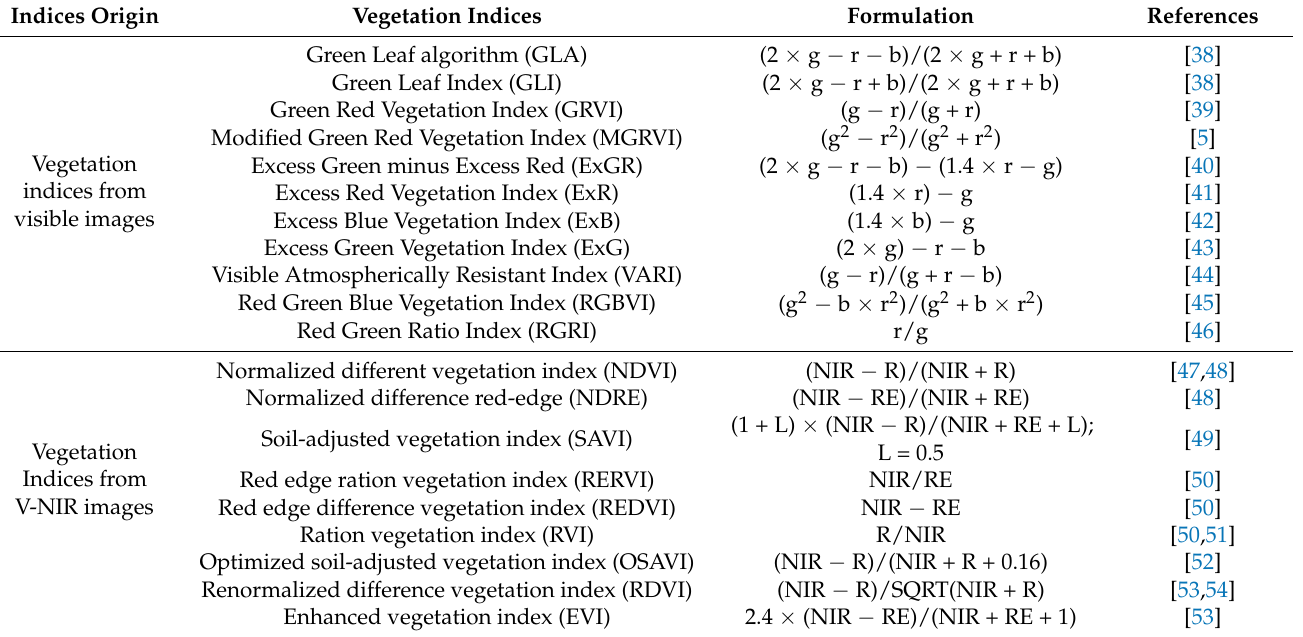
Table 3. List of VIs from V images and V-NIR images used in this